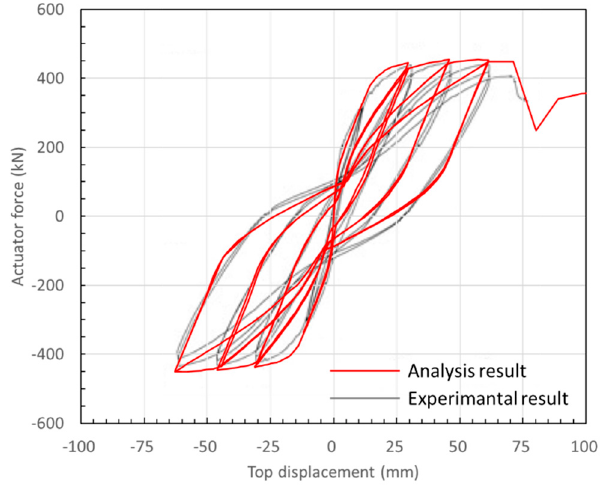
Figure 5. Comparison of experimental result and analysis result [14].